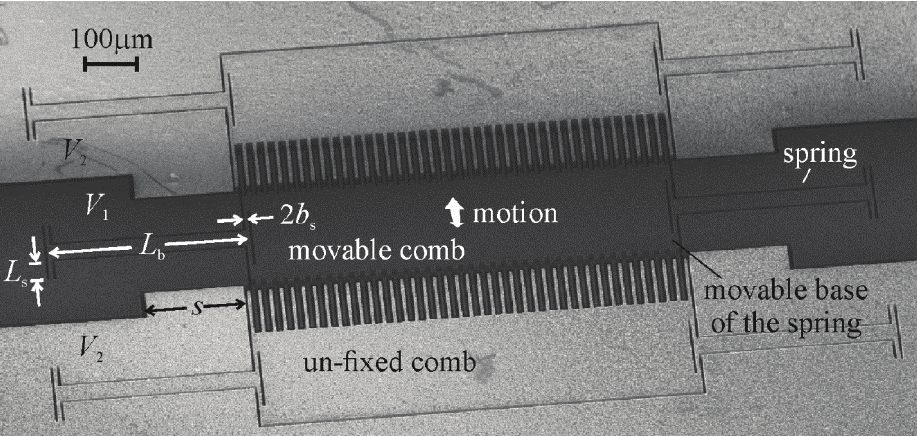
Figure 9. The vertical comb drive design that has its “fixed” combs also attached to springs so that they can be pushed down with the electrical probes to allow the electrostatic forces between the fixed and movable teeth to be measured over a larger range of vertical offsets. The thickness of the narrow spring beams, 2 a s , is equal to the thickness of the device layer the comb drive is etched